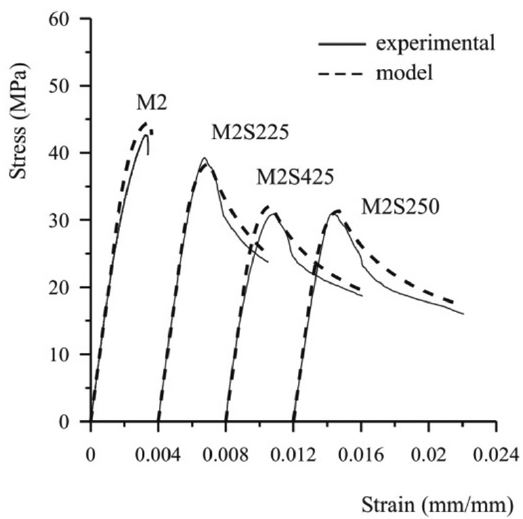
Figure 8. Experimental and analytical stress-strain curves for appropriate matrix.